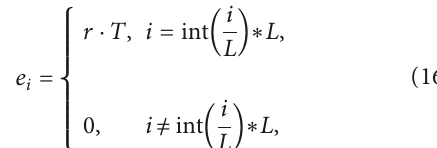
Table 5: Performance of the three boxplots with L